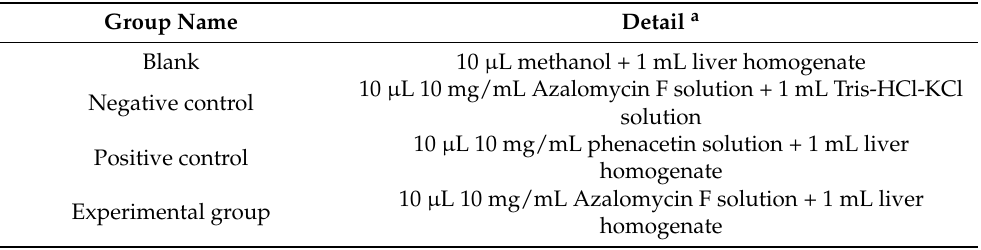
Table 1. The grouping of liver homogenate experiment ( n =